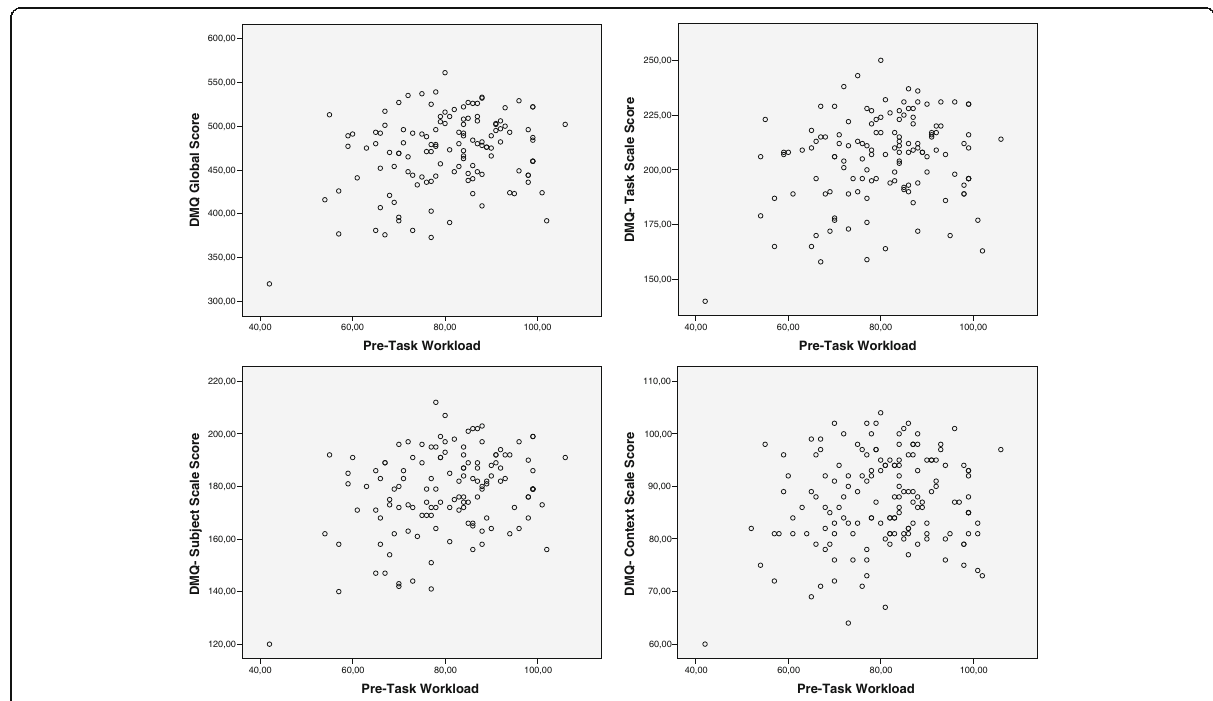
Fig. 1 Scatter plots. DMQ (Decision-Making Questionnaire) vs. Pre-Task Workload. DMQ Decision-Making